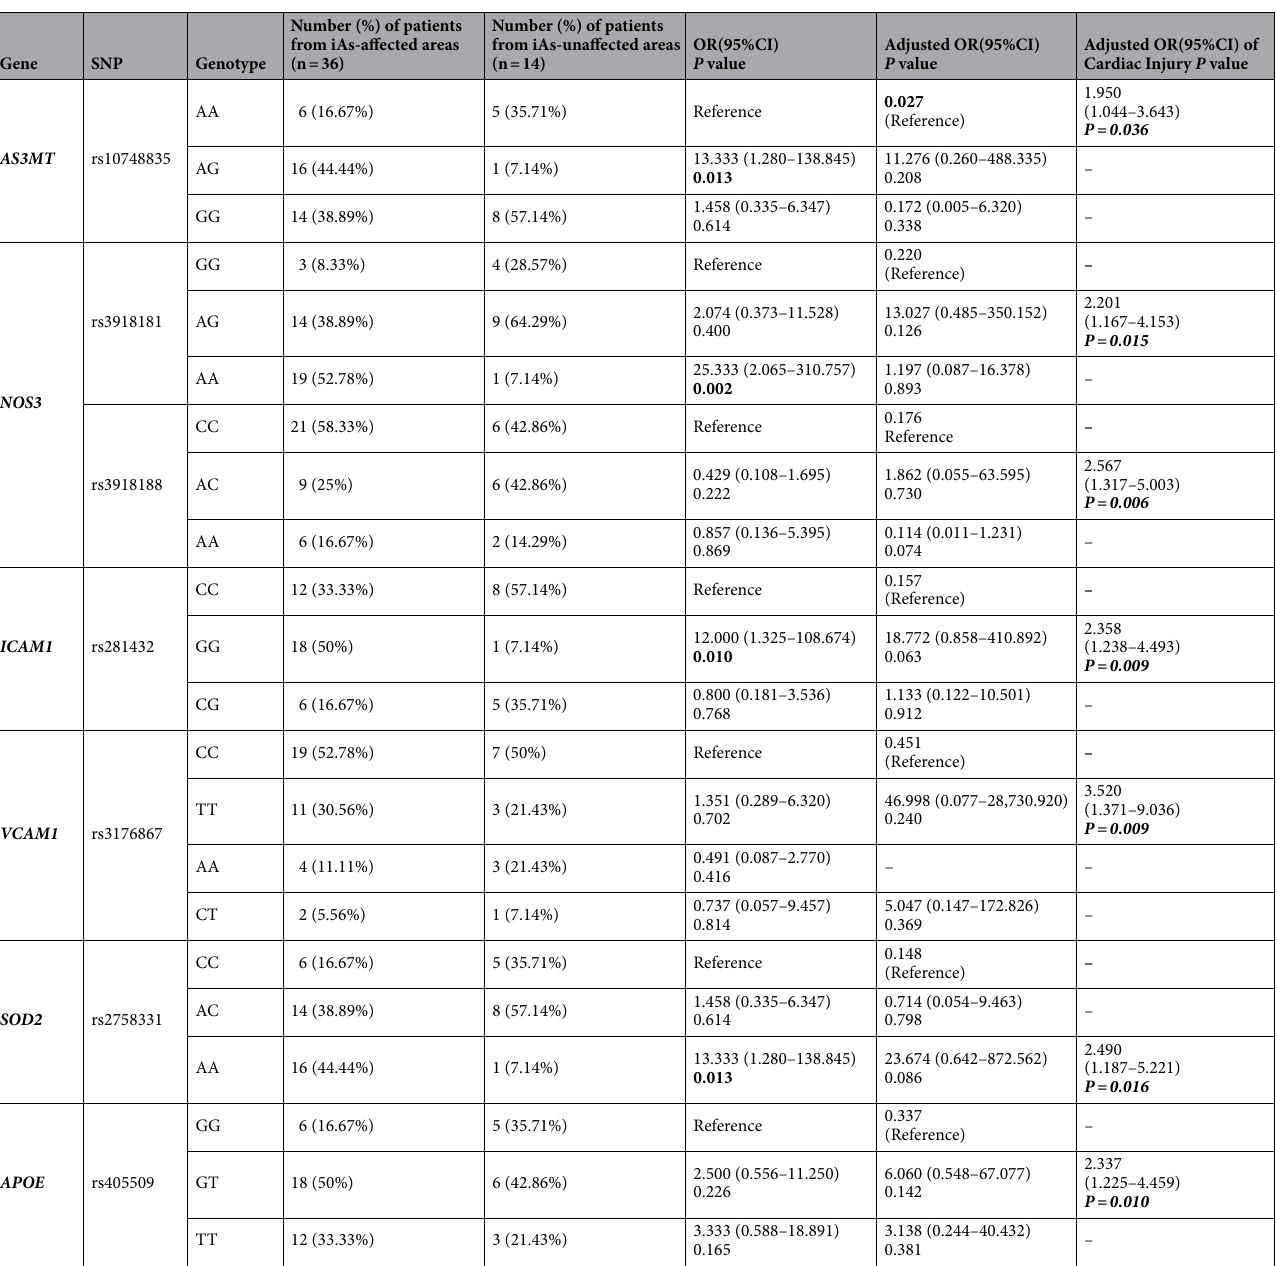
Table 4. Distribution of genotype frequencies among the patient groups. The data were analyzed by Chi- square Test and shown as mean ± SE value. The association analyses were then adjusted for age, sex, BMI, hypertension and diabetes and analyzed by binary logistic regression. Significant values ( P < 0.05) are typed in bold